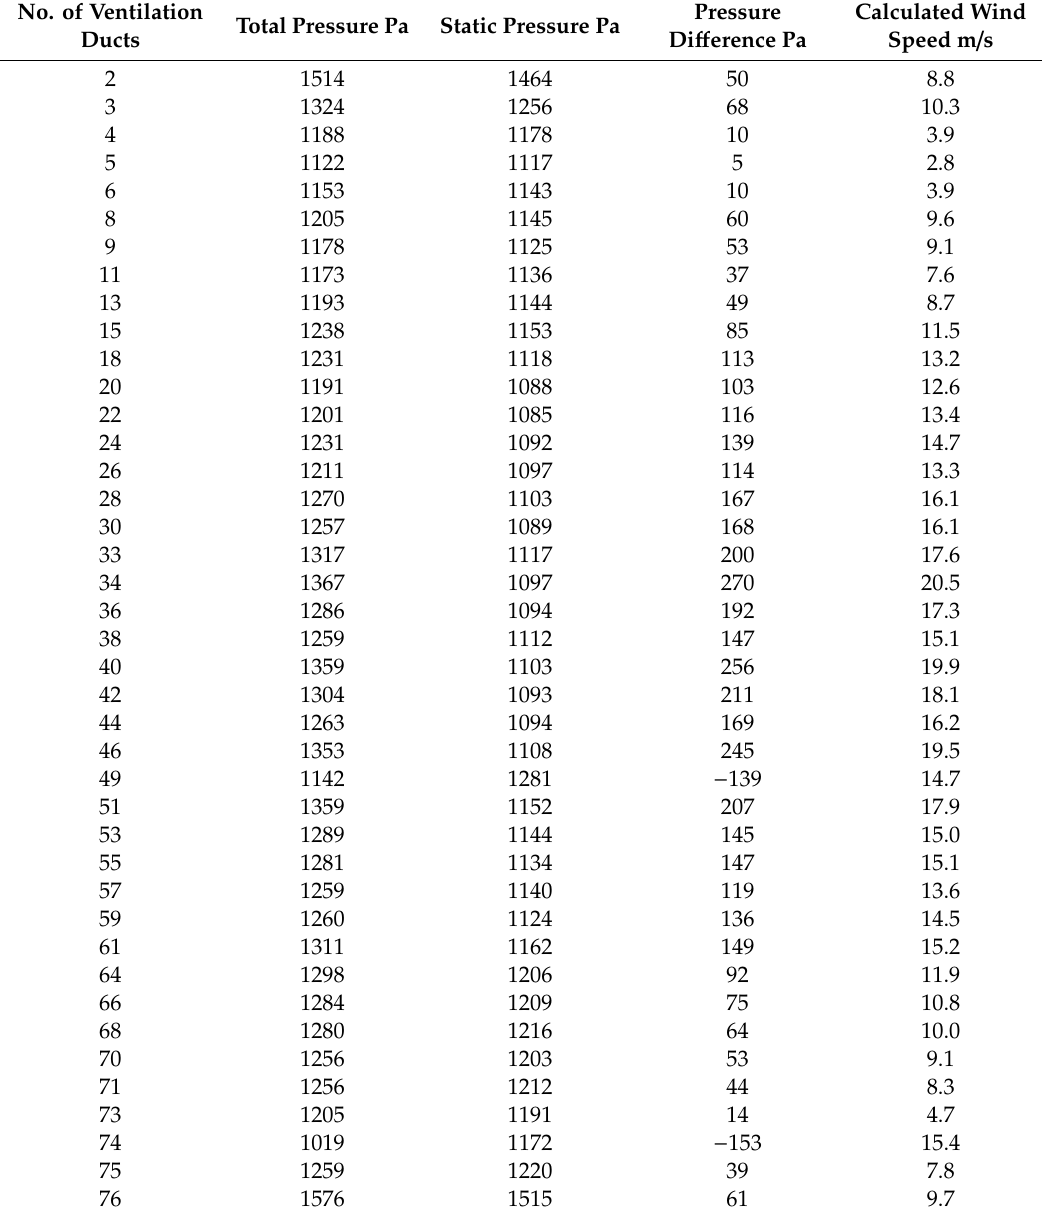
Table 1. Pressure and flow velocity measurement results in stator radial ventilation